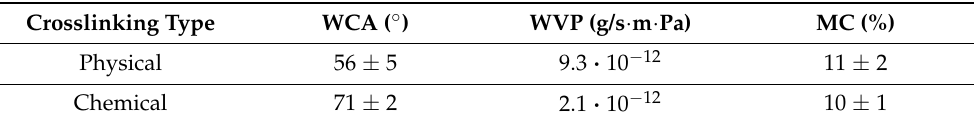
Table 1. Summary of the water-related properties (i.e., water contact angle WCA, water vapour permeability WVP, and moisture content MC) evaluated for chitosan-based